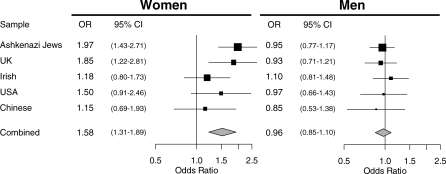
Risk Effects of the GG Genotype of rs7341475 Estimated by Odds Ratio Separately for Men and Women across SamplesThe point estimate of the odds ratio for each sample is represented by a square with a size proportional to the weight of study. The 95% confidence interval (95% CI) for each study is represented by a horizontal line. The confidence interval for the combined data is represented by a diamond.